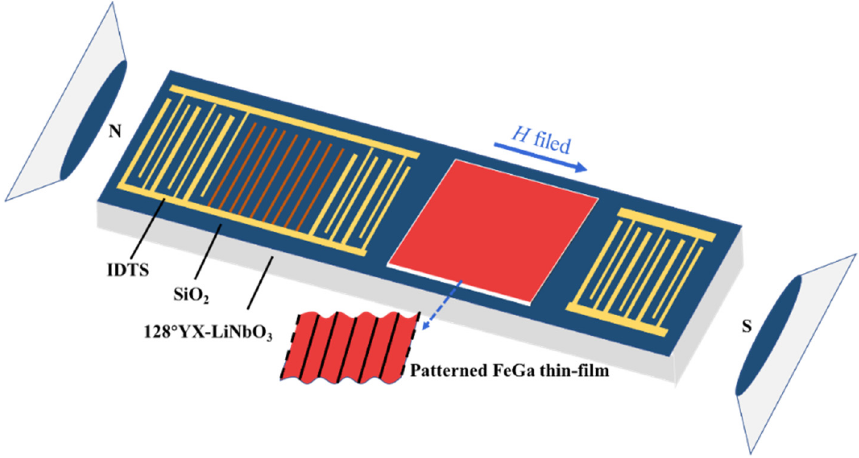
Figure 1. The scheme of patterned FeGa thin film coated SAW sensing device.